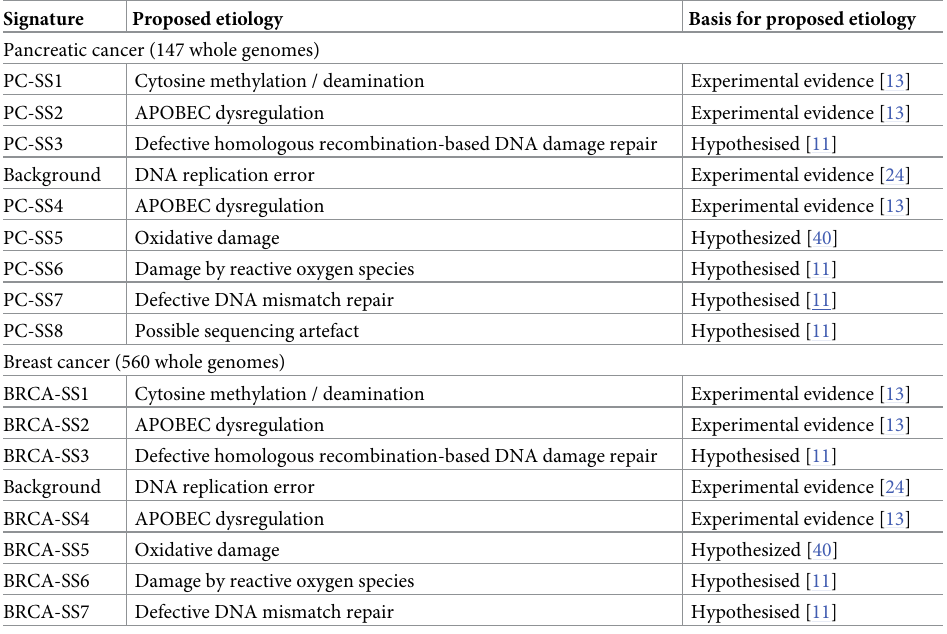
Table 1. Signatures (including background) discovered by SparseSignatures in real cancer data, and their pro- posed